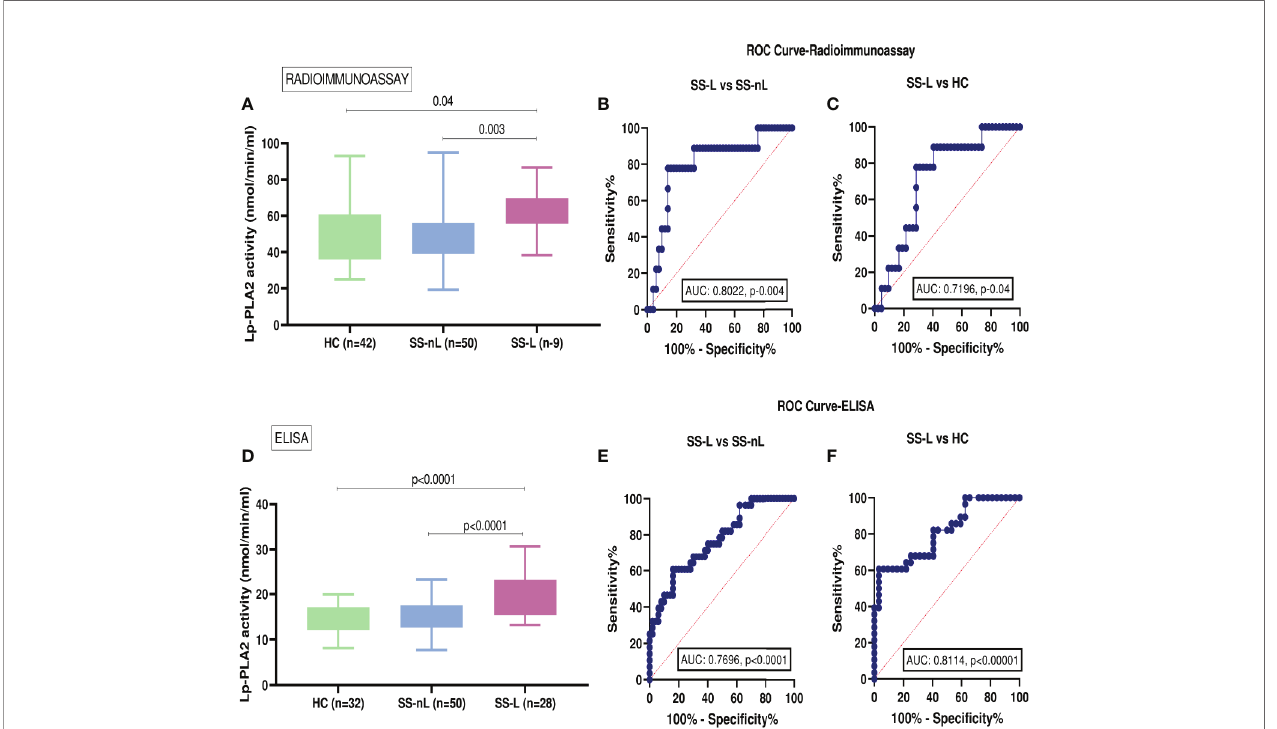
FIGURE 1 | Serum Lp-PLA2 activity in the two SS sets of samples and receiver-operating characteristic analysis (ROC) curve analysis for both radioimmunoassay and ELISA protocols. (A) Increased Lp-PLA2 activity measured by liquid scintillation in SS-L patients compared to SS-nL (p-value: 0.003) and HC (p=0.04). (B) ROC analysis revealed that serum Lp-PLA2 activity measured by radioimmunoassay has the potential to distinguish between SS-L and SS-nL patients [area under the curve (AUC) = 0.8022, CI (95%): 0.64 – 0.96, p-value: 0.004]. (C) When ROC curves for the predictive models were fi tted, AUC were 0.7196, CI (95%): 0.56 – 0.88, p-value: 0.04 for SS-L vs HC. (D) Increased Lp-PLA2 activity measured by ELISA in patients with SS-L compared to SS-nL patients (p-value: <0.0001) and HC (p- value: <0.0001). (E) ROC analysis showed that serum Lp-PLA2 activity measured by ELISA has the potential to distinguish between SS-L and SS-nL patients with AUC 0.7696, CI (95%): 0.66 – 0.88, p-value <0.0001 and (F) For SS-L patients vs HC, ROC curves showed an AUC 0.8114, CI (95%): 0.70 – 0.92, p-value < 0.0001. HC, healthy controls; SS-nL, Sjogren ’ s syndrome without lymphoma; SS-L, Sjogren ’ s syndrome complicated by lymphoma; ROC, receiver operating characteristic; AUC, area under the